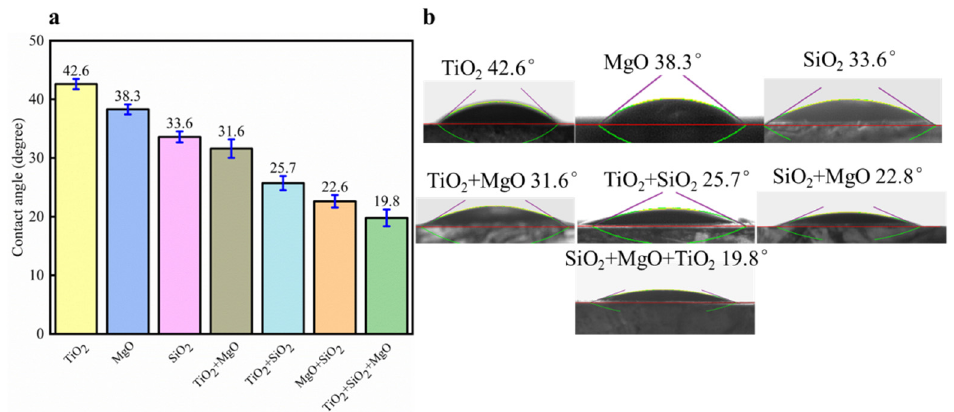
Figure 20. Effect of various nanofluid mixtures on oil-wet calcite wettability. ( a ) Contact angle histogram; ( b ) Measurement figure.